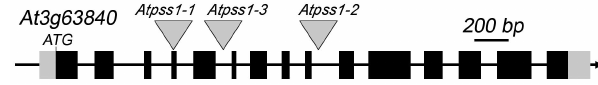
Figure 1. The AtPSS1 gene and mutations. The arrow indicates the orientation of the open reading frame. Exons are shown as boxes (grey: UTR, black: CDS). In Atpss1-1 , Atpss1-2 and Atpss1-3 corresponding to WiscDsLox_343E05, SALK_120399 and SALK_024926 lines, the T-DNA was inserted as indicated by triangles. figure 2. At leptotene chromosomes appear as thin threads (Figure 2A), synapsis (the close association of two chromosomes via an SC) begins at zygotene and is complete by pachytene (Figure 2B). The SC is then depolymerized at diplotene and chromosomes condense so that the five bivalents are visible (pairs of homologues connected by COs) (Figure 2C). The bivalents align at metaphase I (Figure 2D), and chromosomes separate from their homologue at anaphase I leading to the formation of two pools of five chromosomes and two nuclei (Figure 2E). At the second meiotic division, the pairs of sister chromatids align on the two metaphase plates, and separate at anaphase II to generate four pools of five chromosomes, which gives rise to tetrads of four microspores (Figure 2F). In Atpss1 mutants, leptotene and zygotene appeared similar to those in wild type (Compare figure 2A and 2G). Accordingly immunolocalization of two axial element proteins, ASY3 [41] and the hormad domain containing protein ASY1 [42] did not reveal any difference between Atpss1 and wild type (Figure S2). However we were unable to find a typical pachytene stage among chromosome spreads of the Atpss1 mutant (n . 300), as only partial synapsis was observed (Fig- ure 2H). Synapsis was further examined by immunolocalization of REC8 and ZYP1 [43], which are chromosome axis and SC central element proteins, respectively (Figure 3). In flower buds whose size corresponds to late pachytene/diplotene stages, most wild-type cells showed almost complete synapsis, with the ZYP1 signal covering completely the REC8 signal (Figure 3A). In